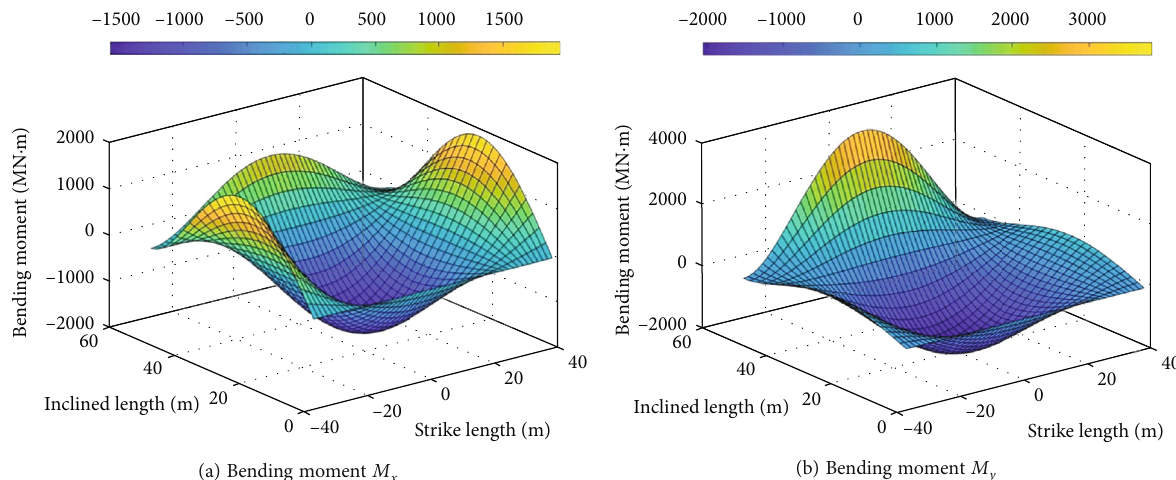
Figure 3: Bending moment of roof model with three sides fi xed and one side simply supported (the simply supported side is the long side).